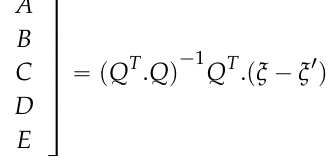
Figure 5. Walking trajectory.